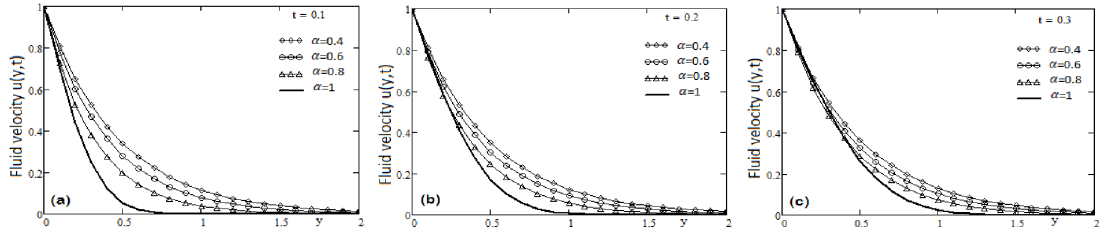
Figure 2. Profiles of velocities for fractional parameter variation for different large time and fixed Reynolds number Re = 3.